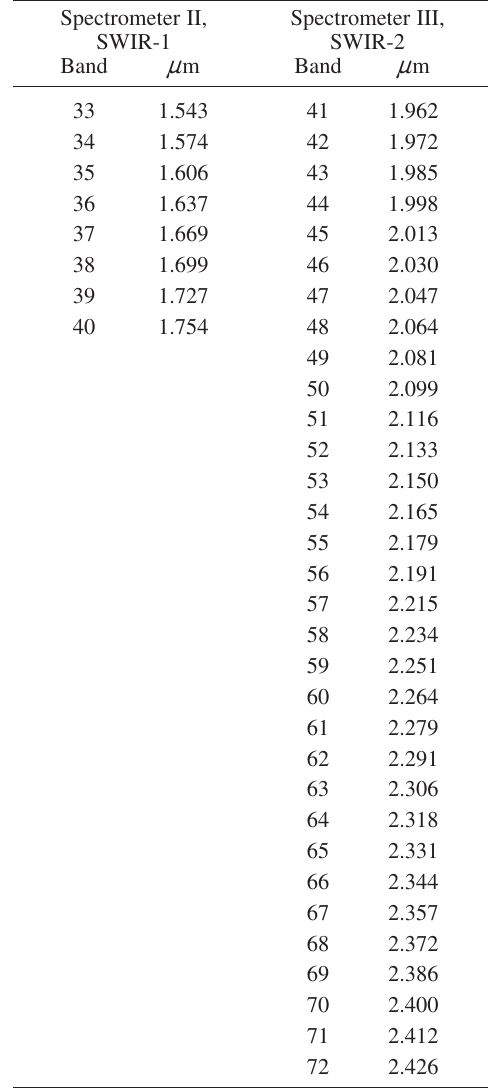
Table II. SWIR-1 and SWIR-2 band